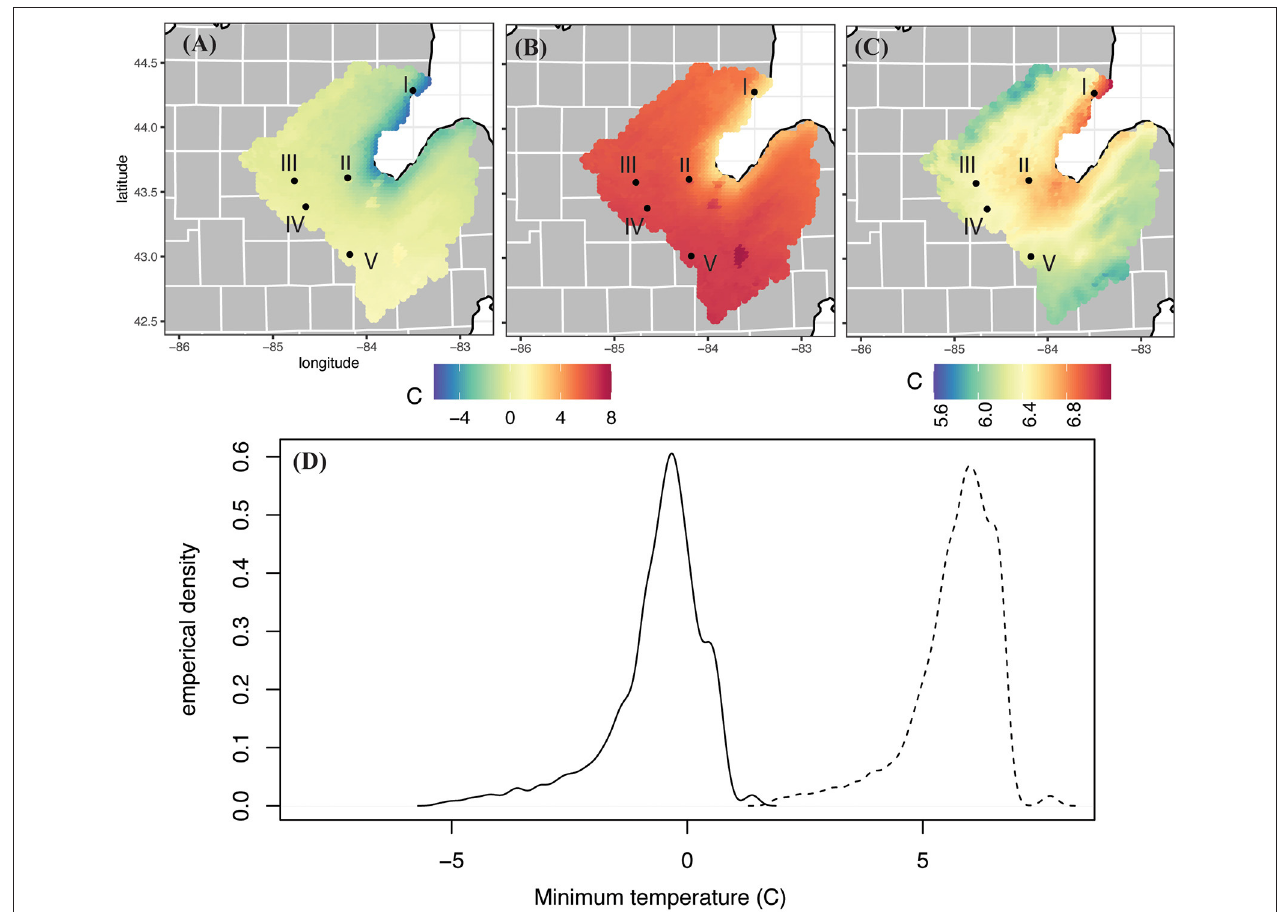
FIGURE 3 | Same as Figure 2 , but for minimum daily